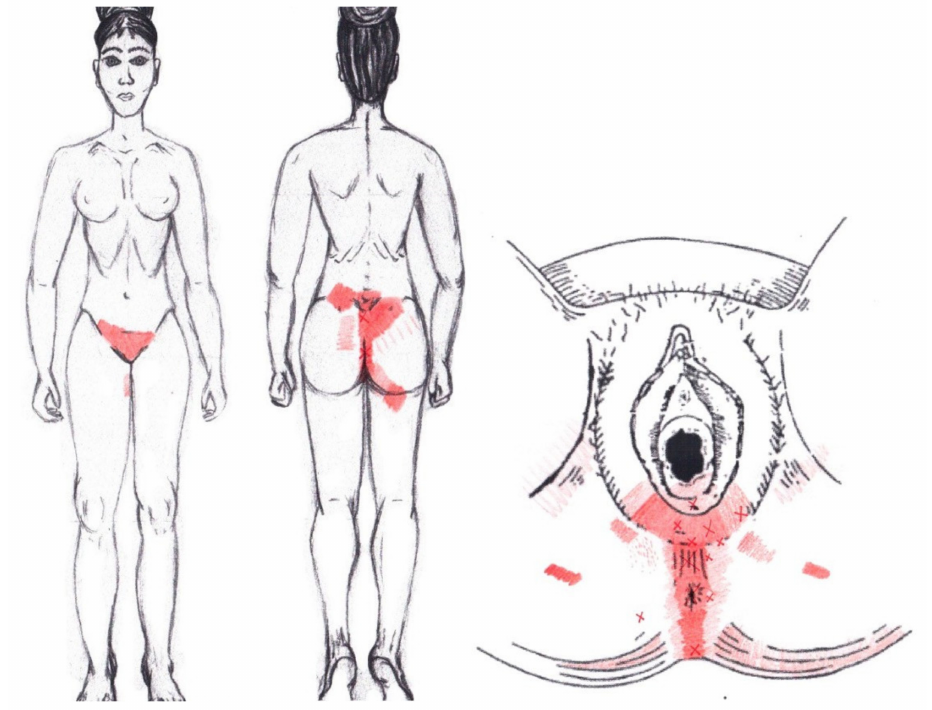
Figure 18. Graphical simulation of referred pain areas of the coccygeus